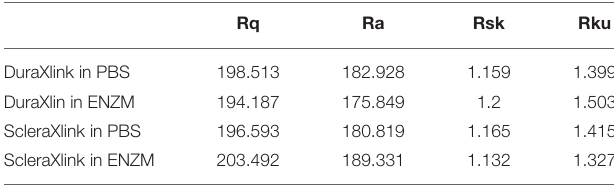
TABLE 1 | Surface roughness of crosslinked dura mater and crosslinked sclera after